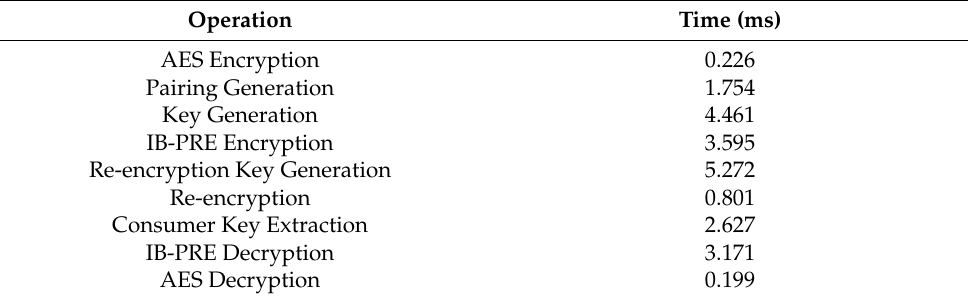
Table 3. Computational Time for each cryptographic